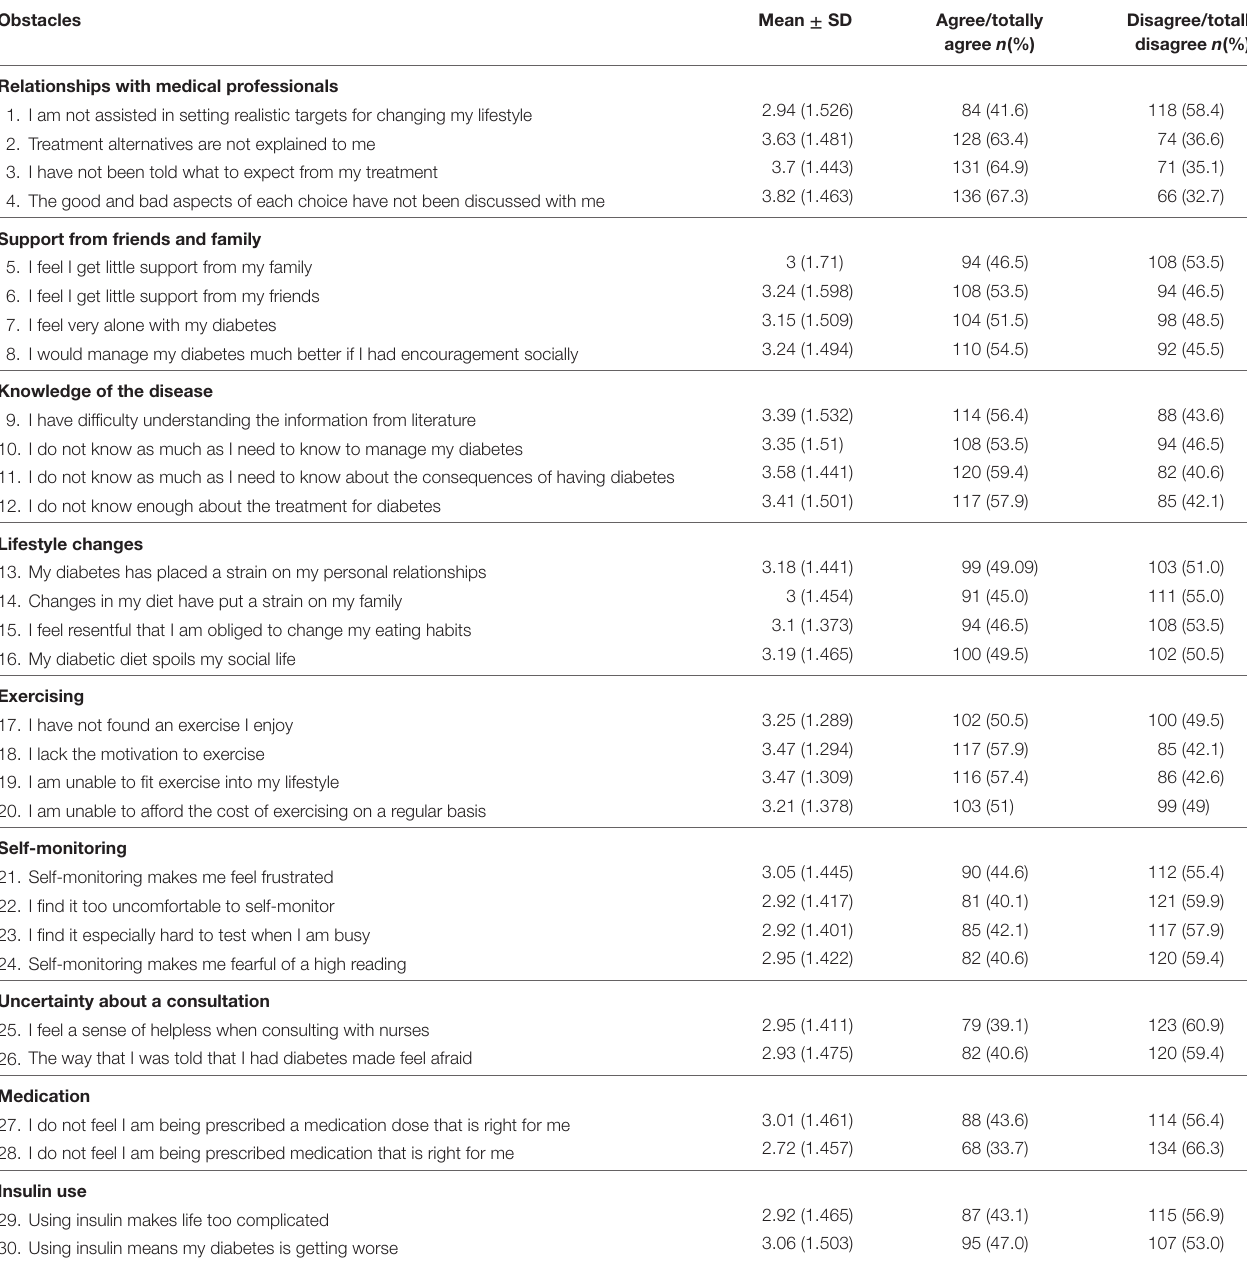
Disagree/totally agree n (%) disagree n (%)